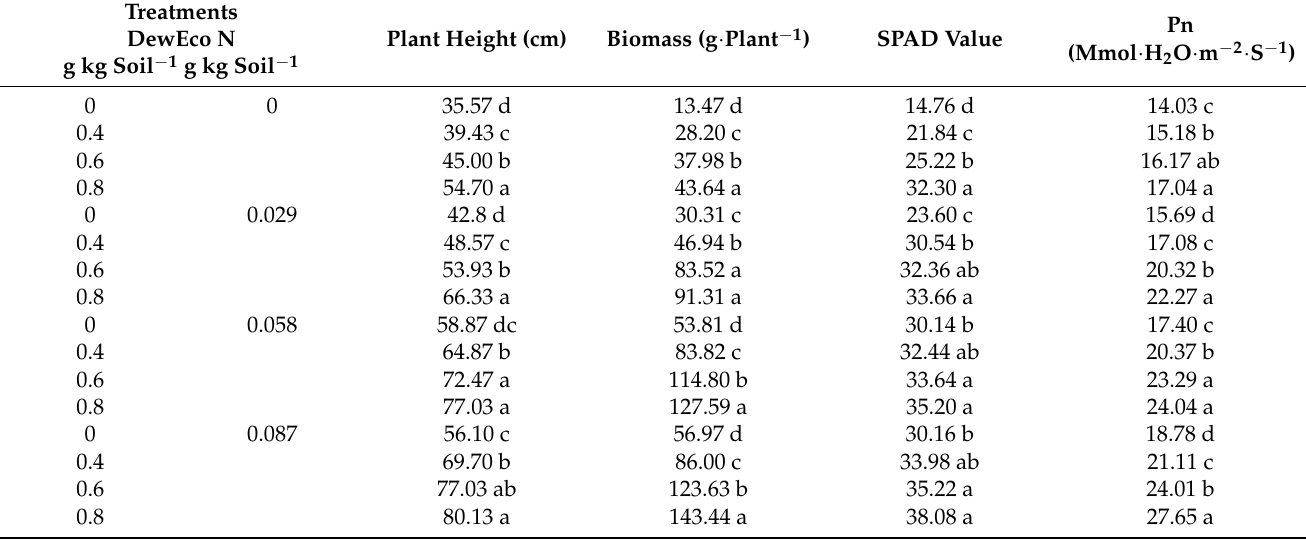
Table 2. Effects of different dosages of DewEco and N application on maize growth, chlorophyll level (SPAD value) and photosynthesis rate ( P